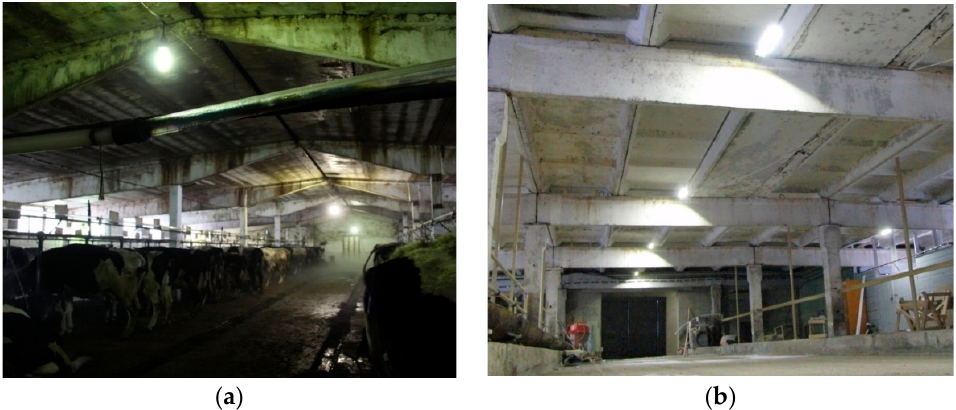
Figure 7. Comparison of illumination systems for cattle-keeping premises: ( a ) cowshed for 200 with illumination by high-pressure lamps with a power of 125 W; ( b ) cowshed for 150 heads with illumination by LED lamps with a power of 9 W.